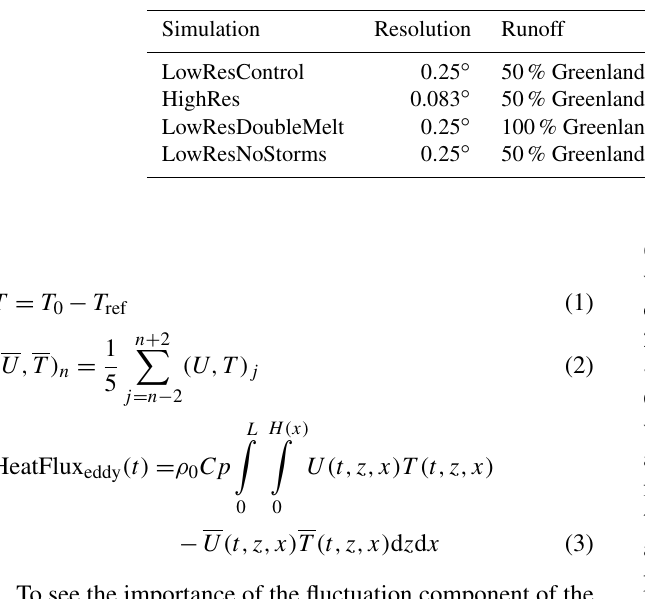
Table 1. ANHA-NEMO simulations used in this study. All experiments include interannual river discharge from Dai et al. (2009), except for the Greenland region, which is obtained by the Greenland Freshwater Flux (FWF) provided by Bamber et al. (2012). All simulations use the same atmospheric forcing, CGRF (Smith et al., 2014), but with the winds and air temperature filtered in